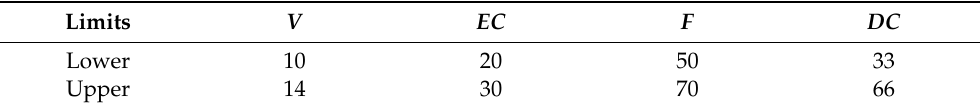
Table 6. Limits of parameters.